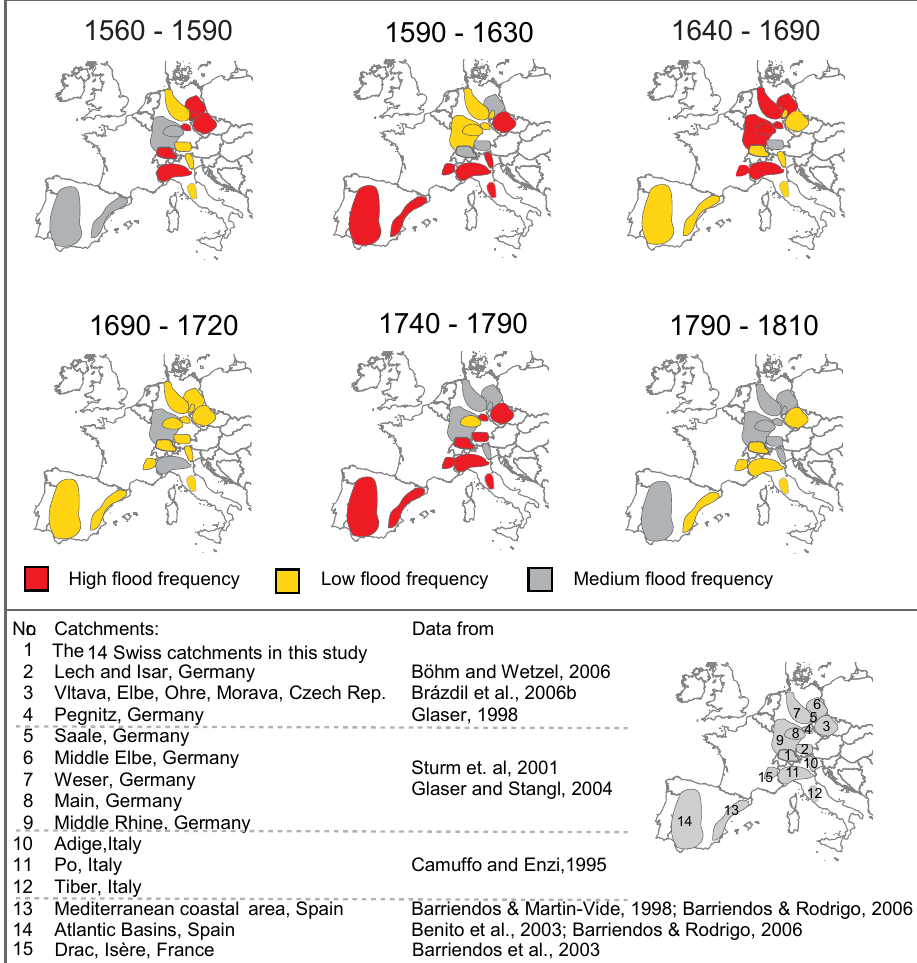
Fig. 7. Schematic presentation of spatial and temporal distribution of periods with very frequent and less frequent flooding in Europe for selected periods between 1560 and